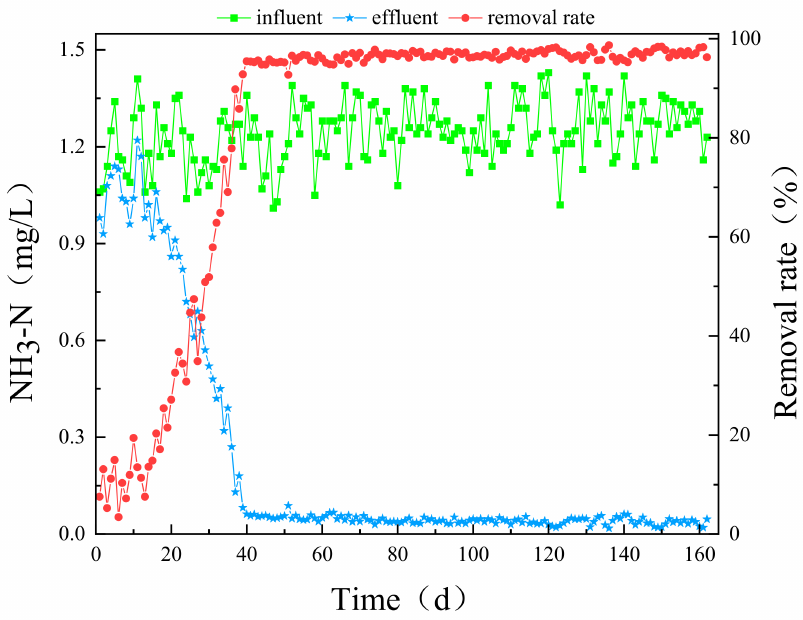
Figure 5. Ammonia use reduction in aeration biofilter